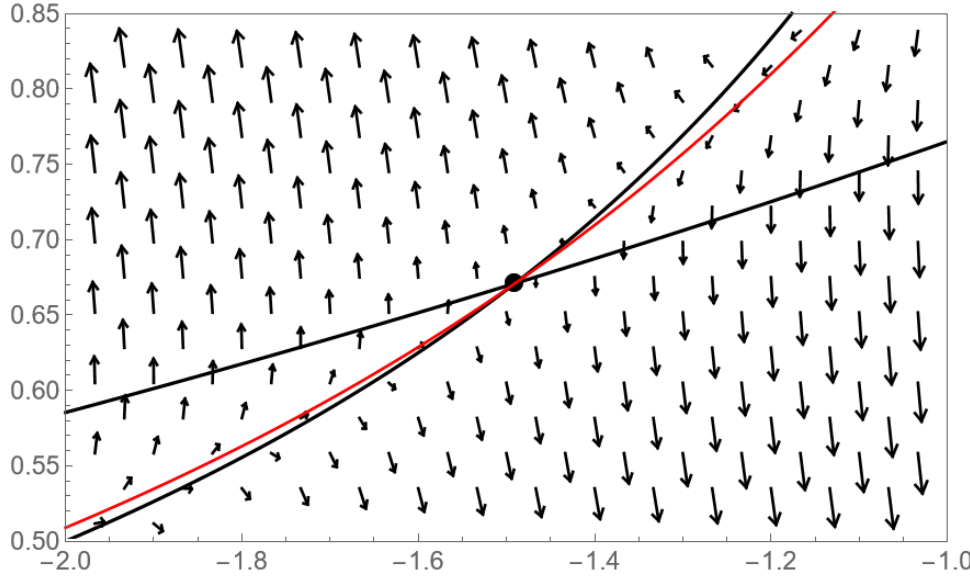
Figure 1. Phaseplot of the steady